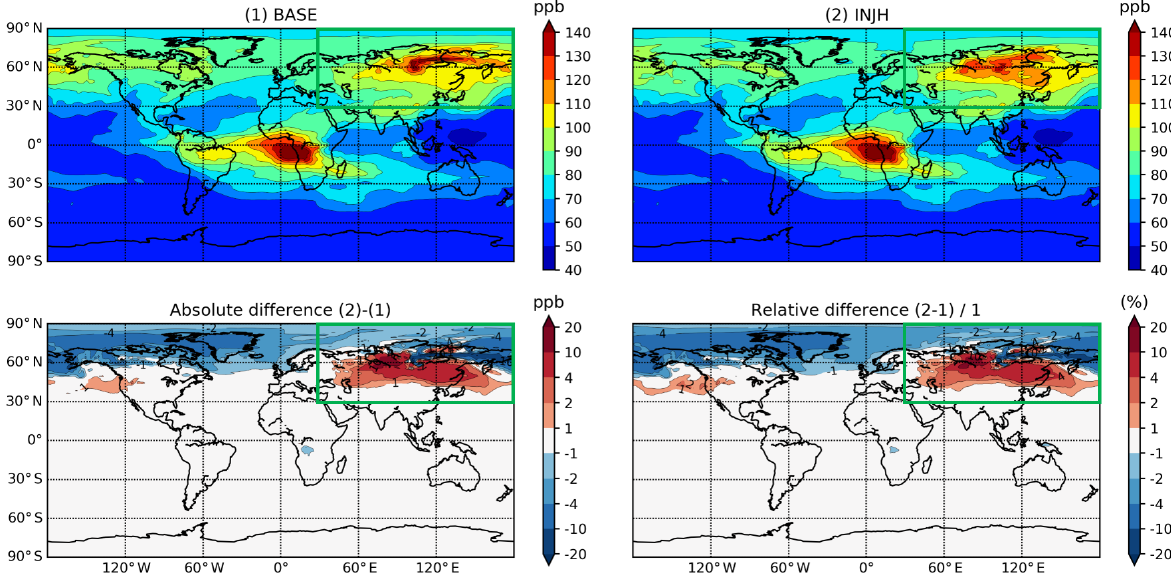
Figure 9. Monthly mean differences of CO mixing ratios between the BASE and INJH MOCAGE simulations on a 350hPa isosurface for the month of August 2013. The green box indicates the area used for the zonal mean.